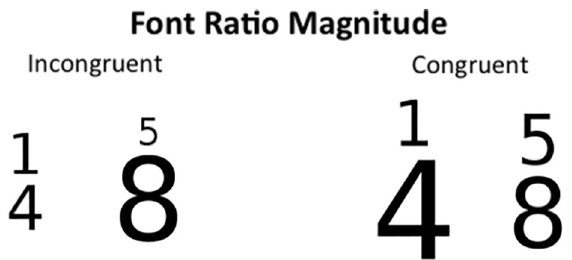
Figure 4. Nonsymbolic font ratio was defined as the ratio of the physical area occupied by the numerator to that occupied by the denominator in fractions used in a comparison task. When the fraction with the larger nonsymbolic font ratio was congruent with the numerical comparison task (i.e., on the same side as the numerically larger fraction), participants were faster and more accurate compared to when nonsymbolic ratio was incongruent (adapted from Matthews & Lewis, 2017).